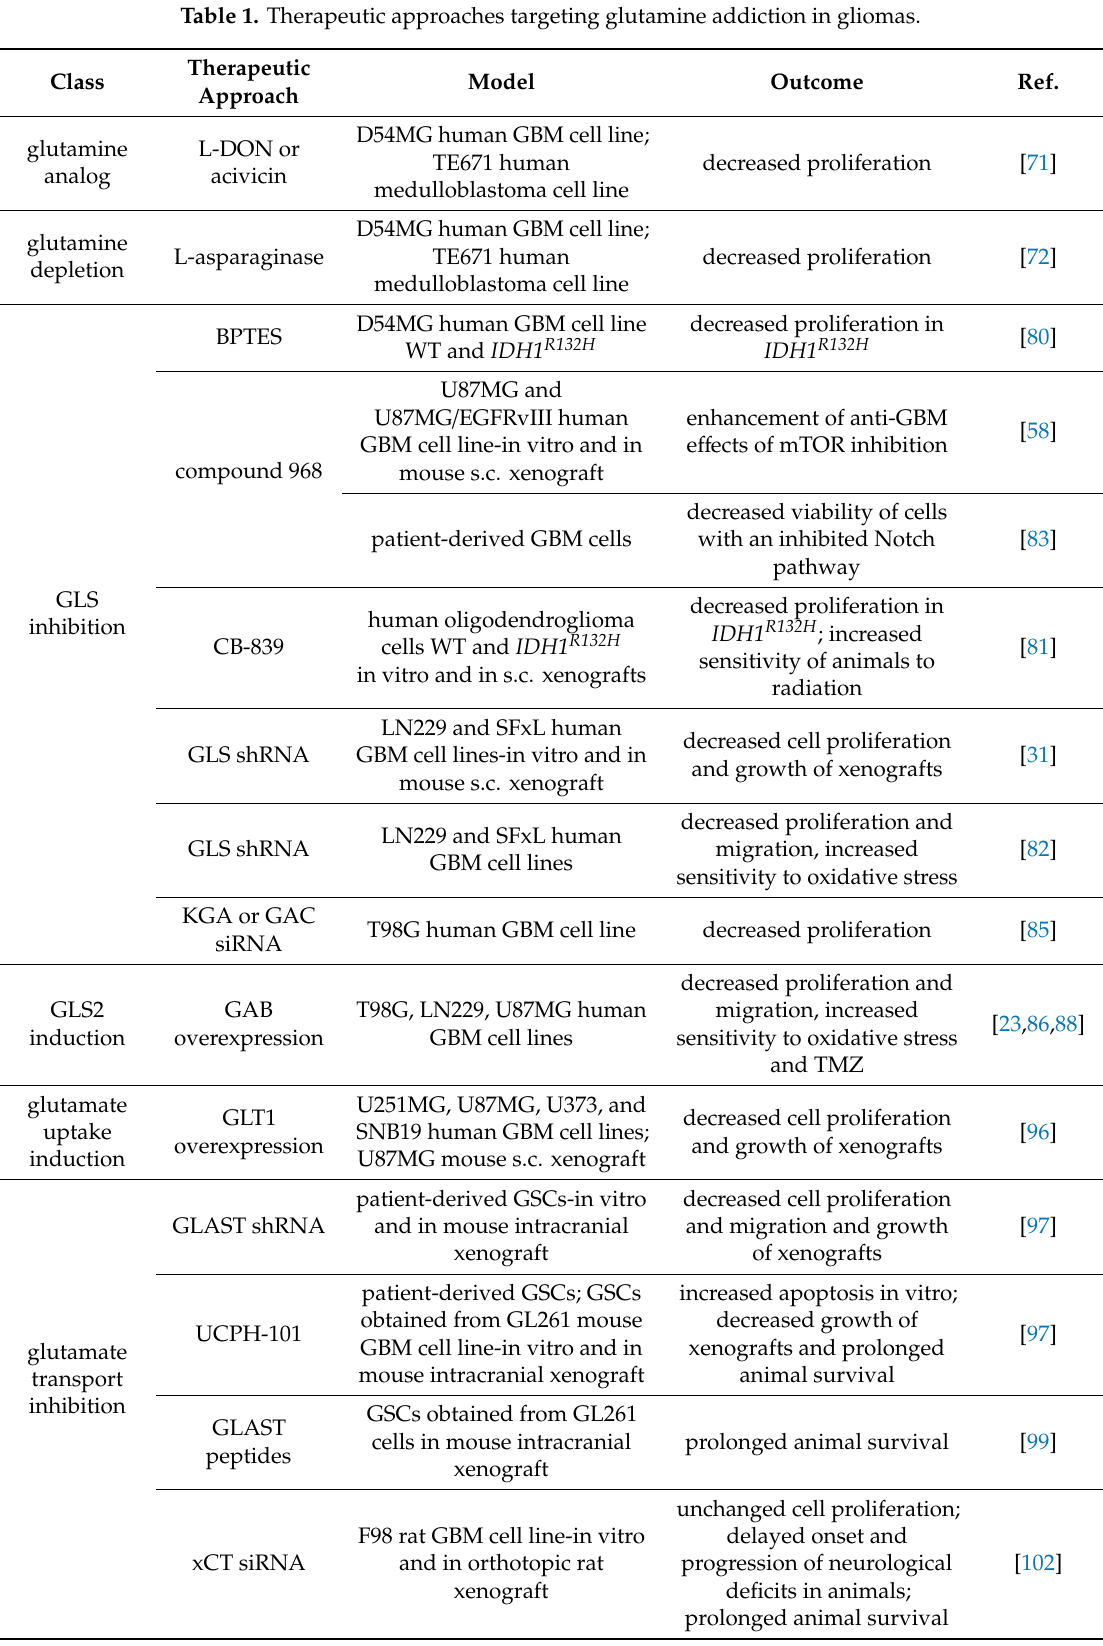
Table 1. Therapeutic approaches targeting glutamine addiction in